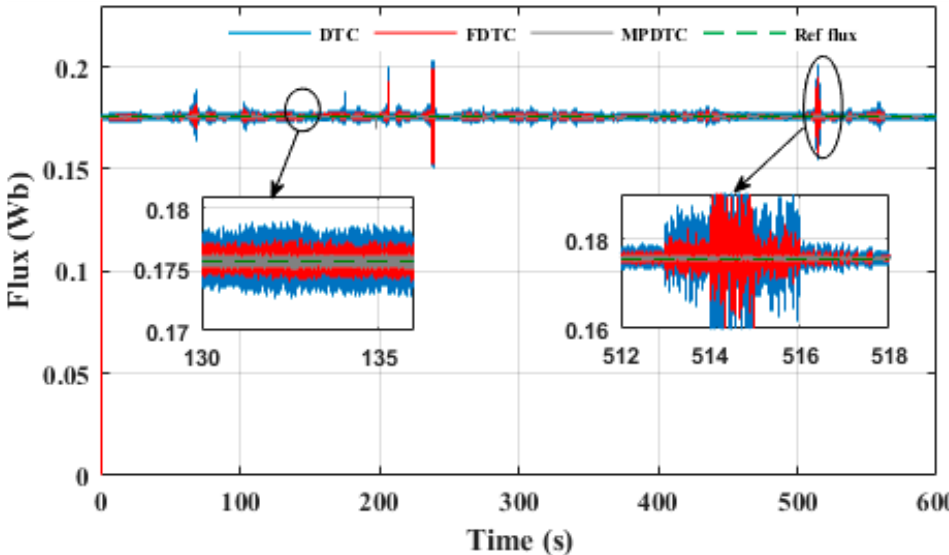
Figure 16. Stator flux responses of the PMSM under different control techniques with NYCC driving cycle.